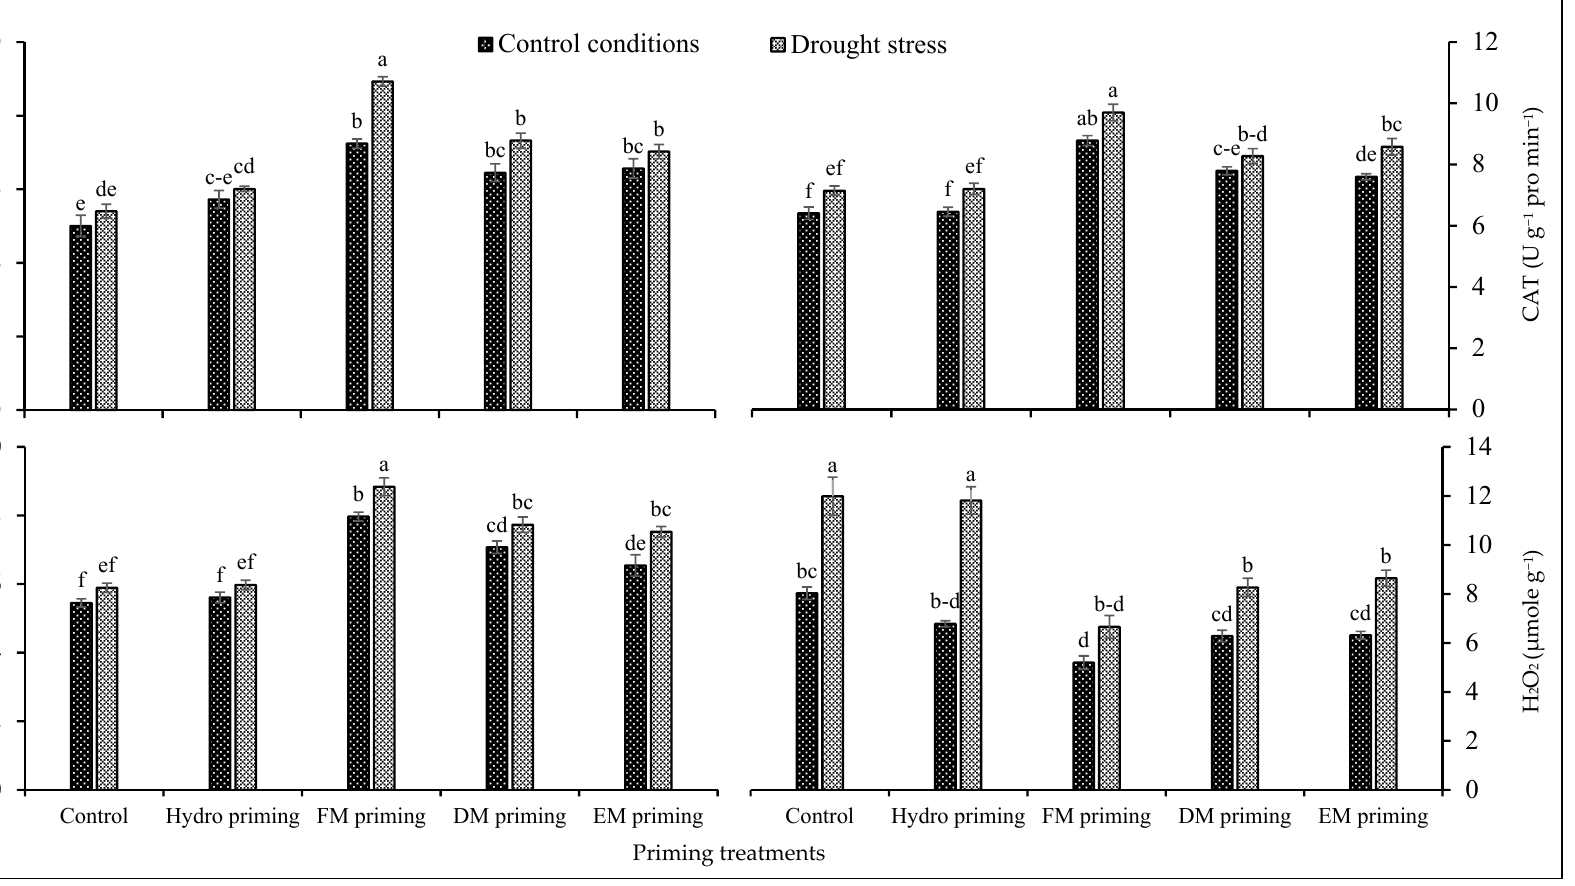
Figure 3. Impact of moringa leaf extracts as priming agents on antioxidant activities of rice seedlings cultivated under control and water deficit regimes. Bars sharing the same letter did not differ significantly at p = 0.05.